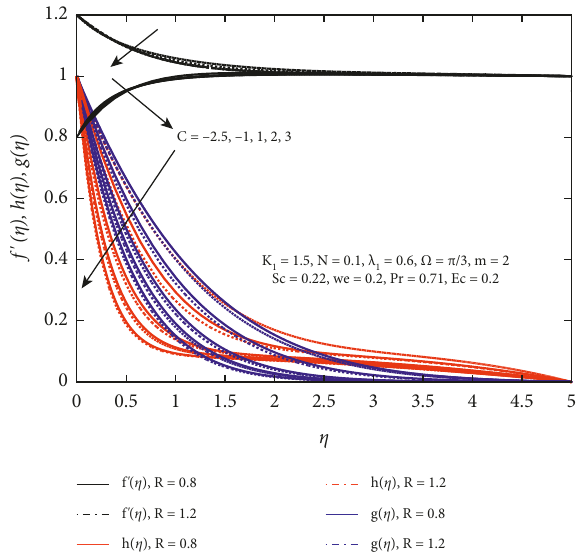
,h ,g η η η for growing values of C 1 . ( ) ( ) ( ) ′